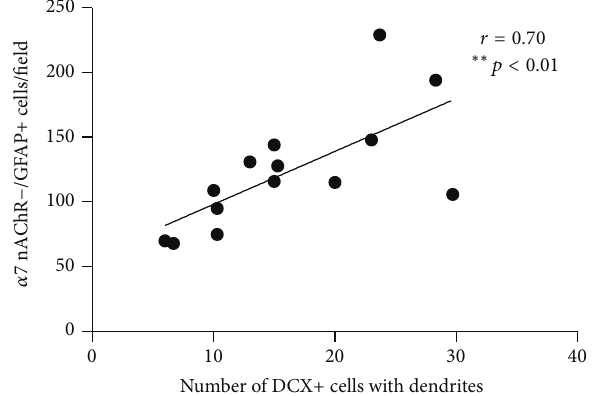
Figure 5: The number of newly generated neurons correlates with the proportion of 𝛼 7 nicotinic receptor-expressing astrocytes in the dentate gyrus of hNSC-transplanted Tg2576 mice. The number of maturing Doublecortin- (DCX+-) labeled cells showed a significant positive correlation with the number of 𝛼 7 nicotinic receptor/glial fibrillary acidic protein-positive (nAChR+/GFAP+) cells in the dentate gyrus of Tg2576 mice ( 𝑟 = 0.70 , ∗∗ 𝑝 < 0.01 , 𝑛 = 13 ). The data are expressed as the mean value for each parameter in the hNSC-transplanted, saline-treated mice (hNSC + SAL) and the hNSC-transplanted, JN403-treated mice (hNSC +